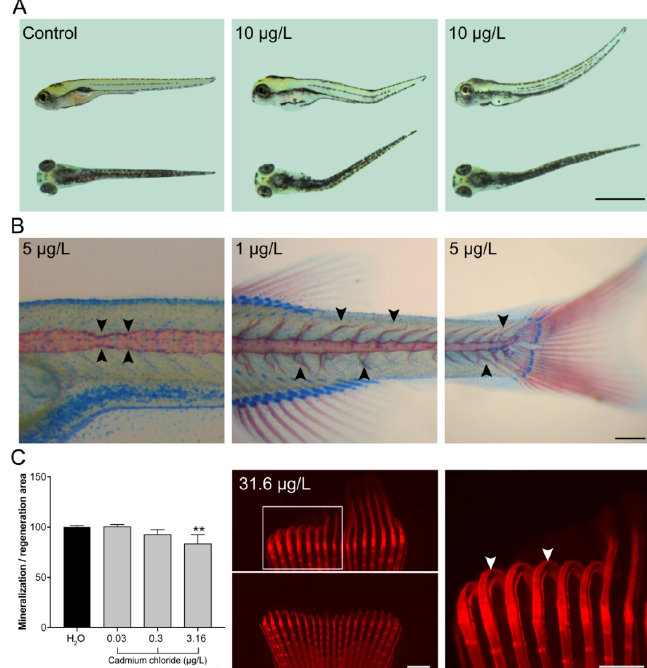
Figure 2. Effects of cadmium on skeletal structures during zebrafish development. ( A ) Bright-field pictures showing vertebral column curvatures in 6-dpf zebrafish larvae exposed for 3 days to 10 µ g/L of cadmium chloride. Lateral (top row) and dorsal (bottom row) views of control (left panel) and cadmium-exposed (middle and right panels) fish. Bar is 1 mm. ( B ) Bright-field pictures illustrating the malformations observed in 20-dpf zebrafish post-larvae exposed for 20 days to 1 or 5 µ g/L of cadmium chloride. Larvae were double stained with alcian blue and alizarin red S. Black arrowheads indicate deformed skeletal structures. Left panel, abdominal and caudal vertebrae compression (platyspondyly); Middle panel, malformation of the caudal vertebrae including neural and hemal arches; Right panel, malformation of the last neural and penultimate hemal arches. Bar is 0.5 mm. ( C ) Impaired bone regeneration in adult zebrafish exposed for 5 days to cadmium chloride determined from the morphometric analysis of fluorescence pictures of alizarin red S stained caudal fin (left panel). Asterisks indicate values statistically different from vehicle values (one-way ANOVA followed by Dunnett’s multiple comparison; ** p < 0.01). Values are presented as percentages and are the mean ± standard deviation (n ≥ 3). Newly formed rays were bended at the highest cadmium concentration (31.6 µ g/L; middle panel). White arrowheads indicate bended lepidotrichia (right panel). Bar is 1